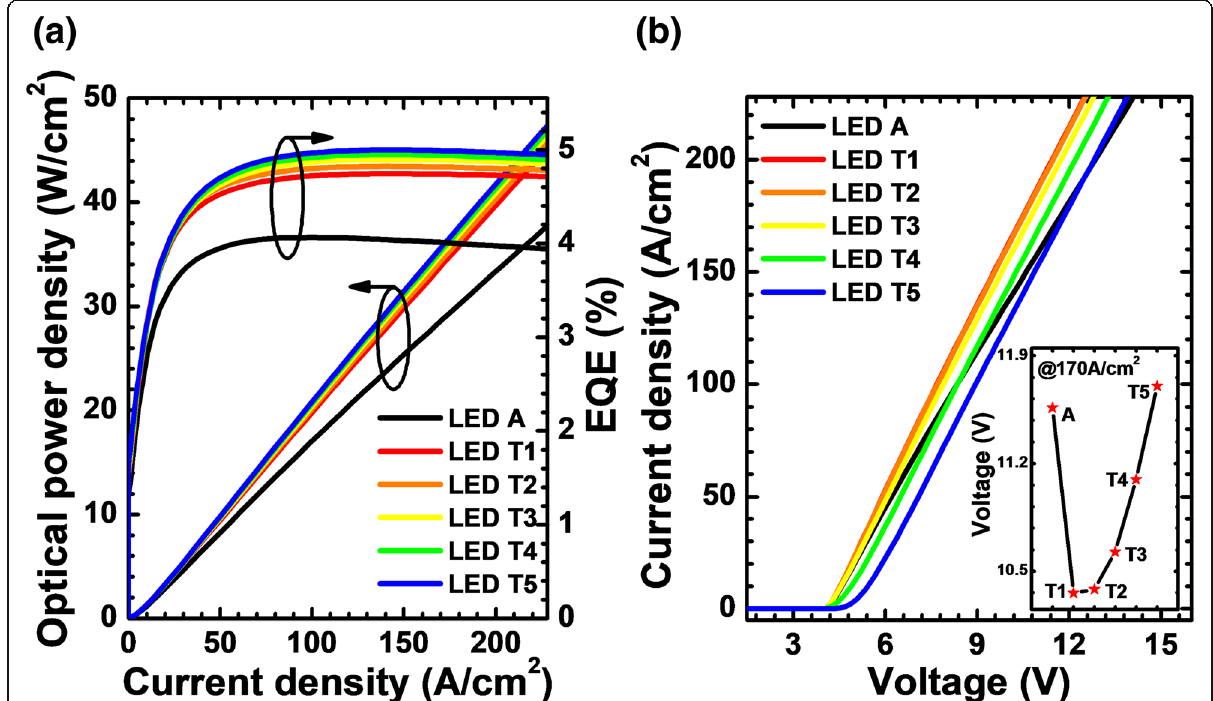
Fig. 13 a EQE and optical power density in terms of the injection current and b current-voltage characteristics for LEDs A and T i ( i = 1, 2, 3, 4, and 5). Inset: the forward voltages for LEDs A and T i ( i = 1, 2, 3, 4, and 5) when the current density is 170 A/cm